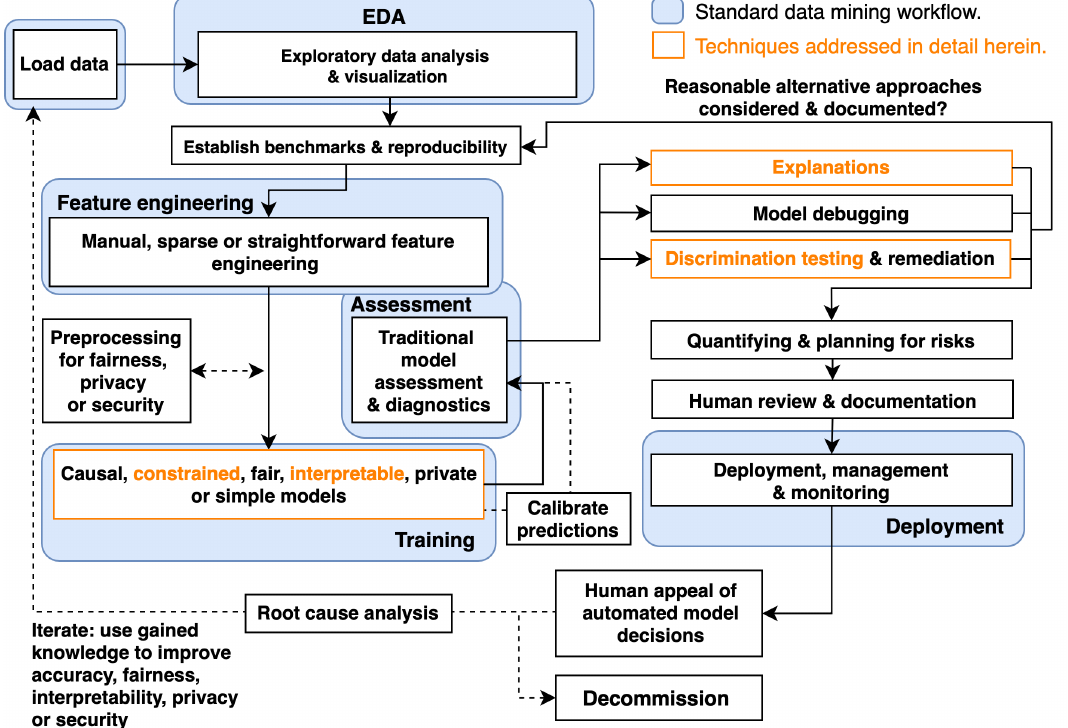
Figure 8. An example responsible ML workflow in which interpretable models, post-hoc explanations, discrimination testing and remediation techniques, among several other processes, can create an understandable and trustworthy ML system for high-stakes, human-centered, or regulated